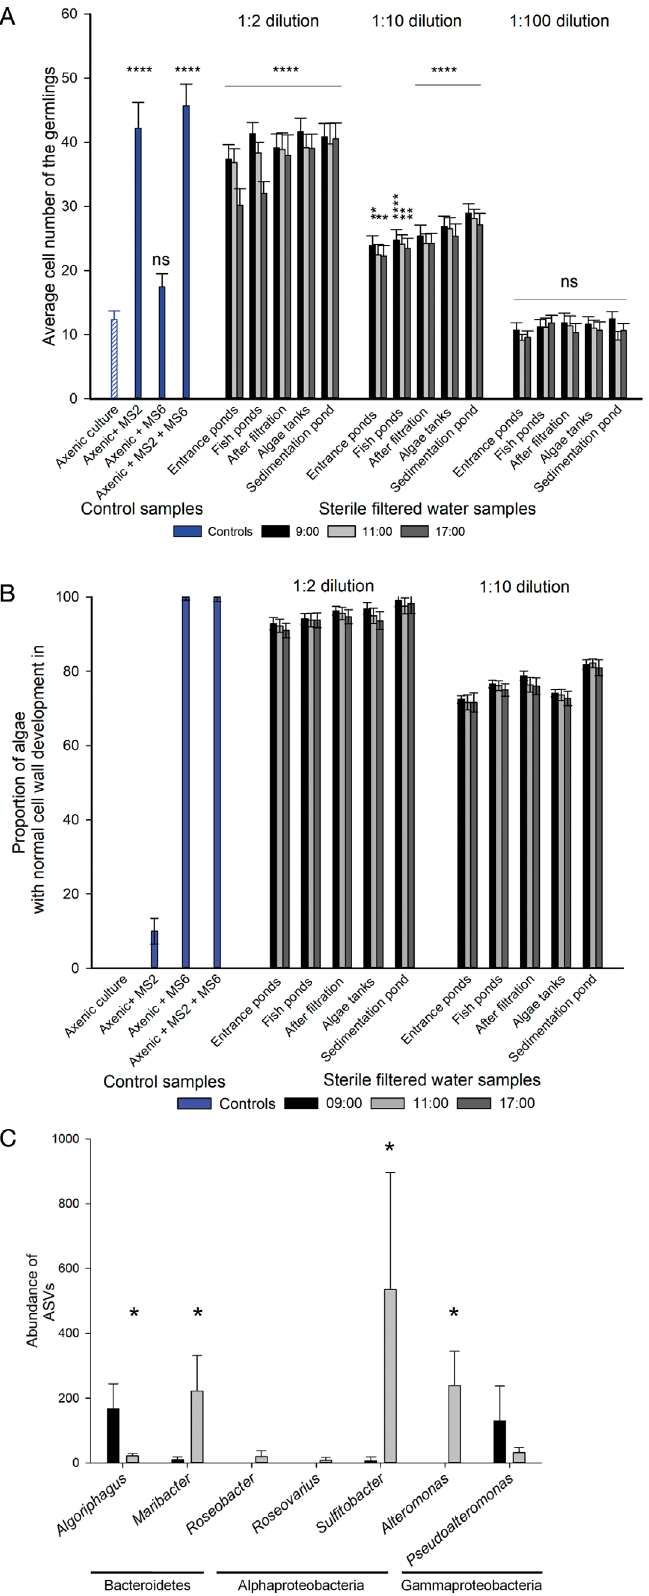
Fig. 3. ‘ Ulva bioassay array’ of the morphogenetic activity of water samples from the aquaculture farm. (A) Potential AGMPFs released by bacteria using dilution series of the ra- tios 1:2, 1:10, and 1:100 of doubly sterile-filtered water sam- ples on axenic U. mutabilis gametophytes. To estimate the activity of the Roseovarius -factor, the total cell numbers in thalli of U. mutabilis plantlets were counted 10 d after inocu- lation. Controls show the morphogenetic activity on gametes without bacteria (axenic), with Roseovarius sp., with the bacterial strain Maribacter sp., and in combination with both bacterial strains. Data were analysed using a Kruskal-Wallis test followed by a multiple comparisons test with Dunn cor- rection for ‘axenic culture’ control versus treated groups. *p £ 0.05; **p £ 0.01; ***p £ 0.001; ****p £ 0.0001; ns: p > 0.05. (B) To determine the activity of the Maribacter -factor, the proportion of thalli of U. mutabilis with normal cell wall development was evaluated as a percentage of total thalli 10 d after inoculation with bacteria listed above as controls, with 1:2 dilution and 1:10 dilution. The effect of the Marib- acter -factor completely vanished at 1:100 dilutions (i.e. 0%, not shown). Error bars in (A) and (B) represent confidence intervals (p = 0.95; n = 45−60 ind. algae). (C) The enrichment of selected bacterial genera in algae tanks (grey bars) or la- goon waters (black bars) was estimated by the abundance of the amplicon sequence variants (ASV). Significant differ- ences are indicated by an asterisk (t -test; *p £ 0.05).